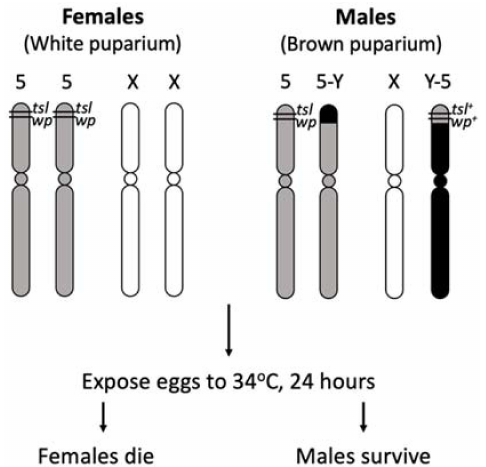
Figure 1. Principle chromosome structure of the Medfly VIENNA-8 GSS strain (Adapted from Franz [26]). Females are homozygous for chromosome 5 temperature sensitive lethal ( tsl ) and white pupae ( wp ) mutations and can be selectively removed with heat applications at the embryo stage. Females reared at permissive temperatures express a white pupae phenotype. Males have wild type tsl + and wp + alleles translocated to the Y chromosome resulting in resistance to temperature selection and a brown